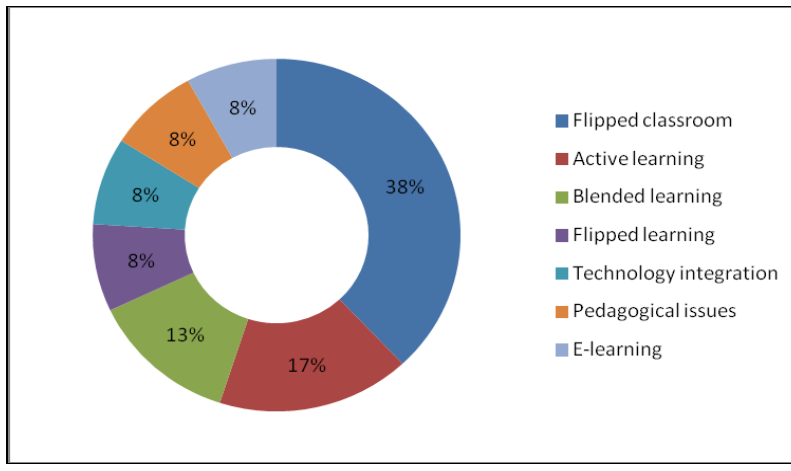
Figure 5. The most commonly used keywords in the flipped learning research